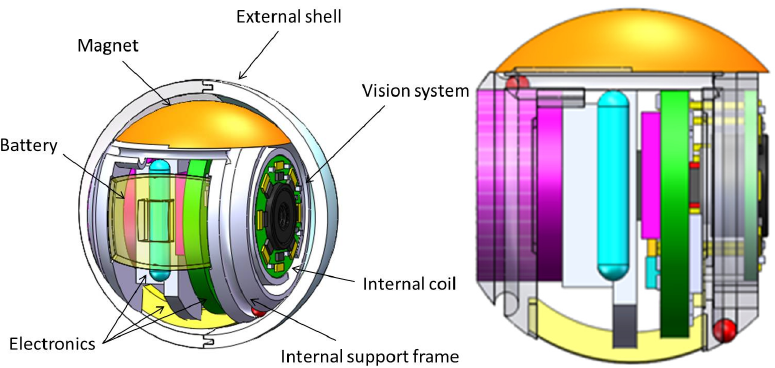
Figure 1. The capsule prototype concept with embedded components ( Left ); lateral view ( Right